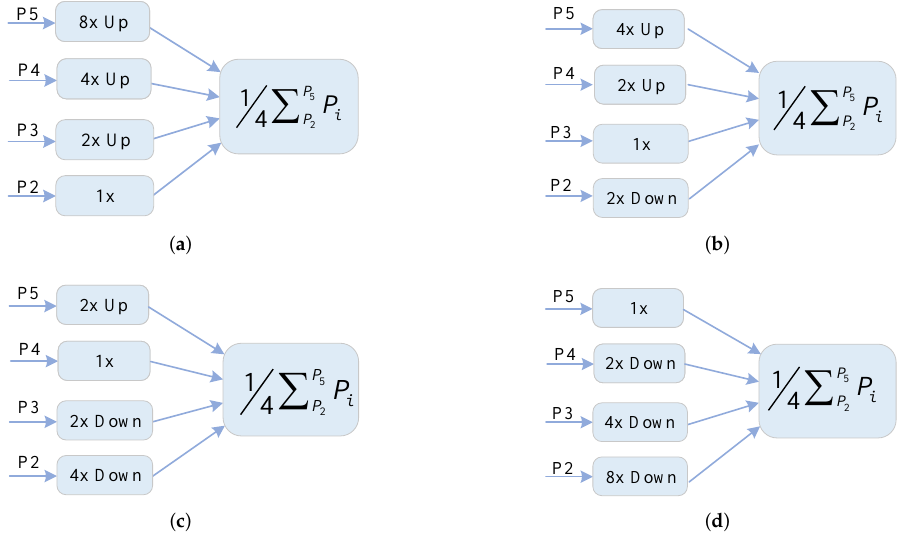
Figure 10. Different integration manners of multi-scale features of P2, P3, P4, P5. ( a ) The way of Integration into P2; ( b ) The way of Integration into P3; ( c ) The way of Integration into P4; ( d ) The way of Integration into P5. Note that Up and Down represent upsample and downsample operations respectively are achieved by the bilinear interpolation method.